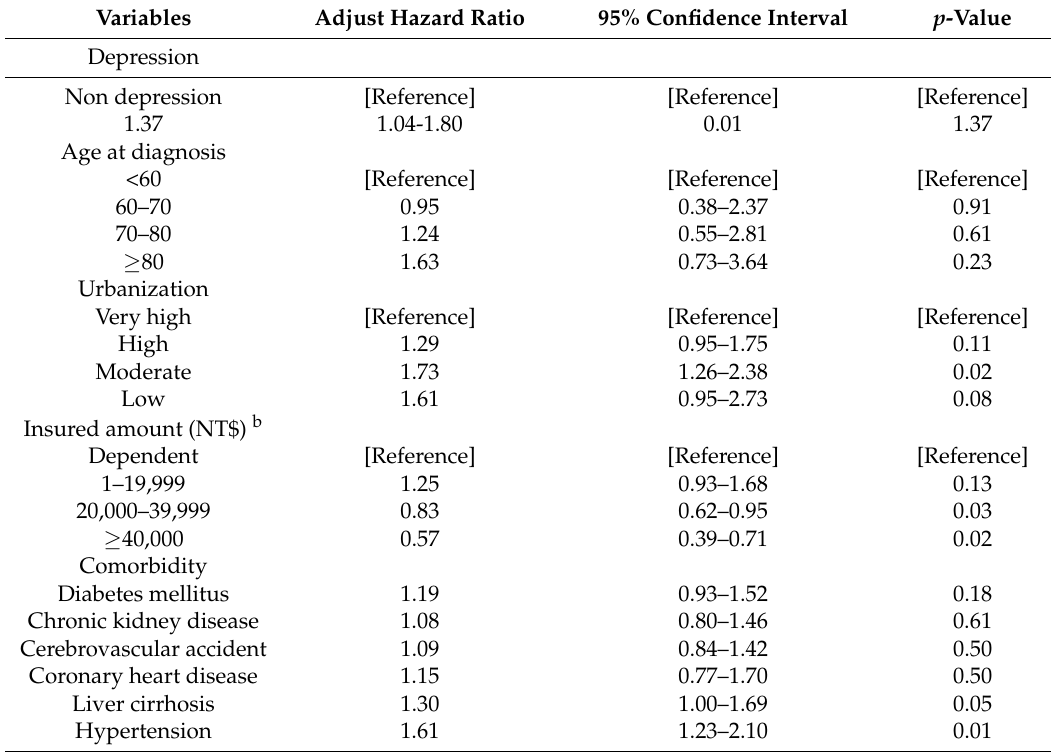
Table 2. Adjusted hazard ratio with 95% confidence interval of the mortality in national prostate cancer